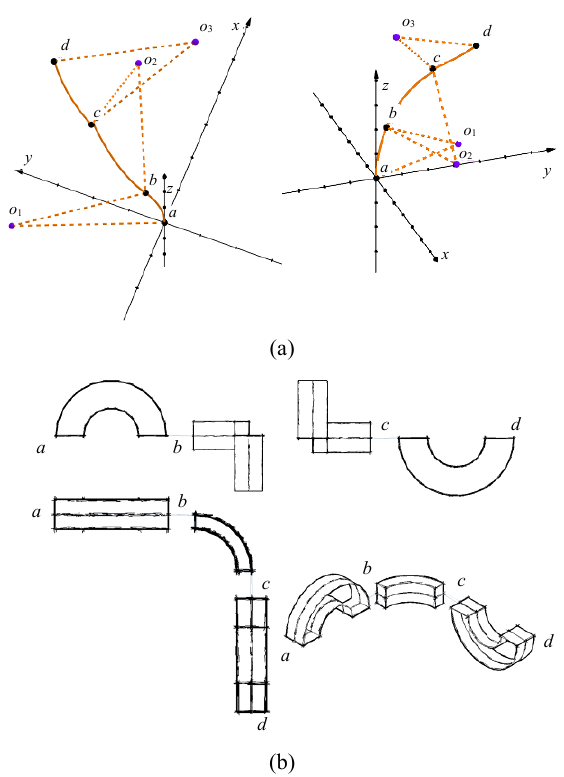
Fig. 12 Comparison of 3D position between the simulation and experiment: (a) the simulation of shape sensing in 3D space observed from different perspectives and (b) the experimental position of shape sensing in 3D